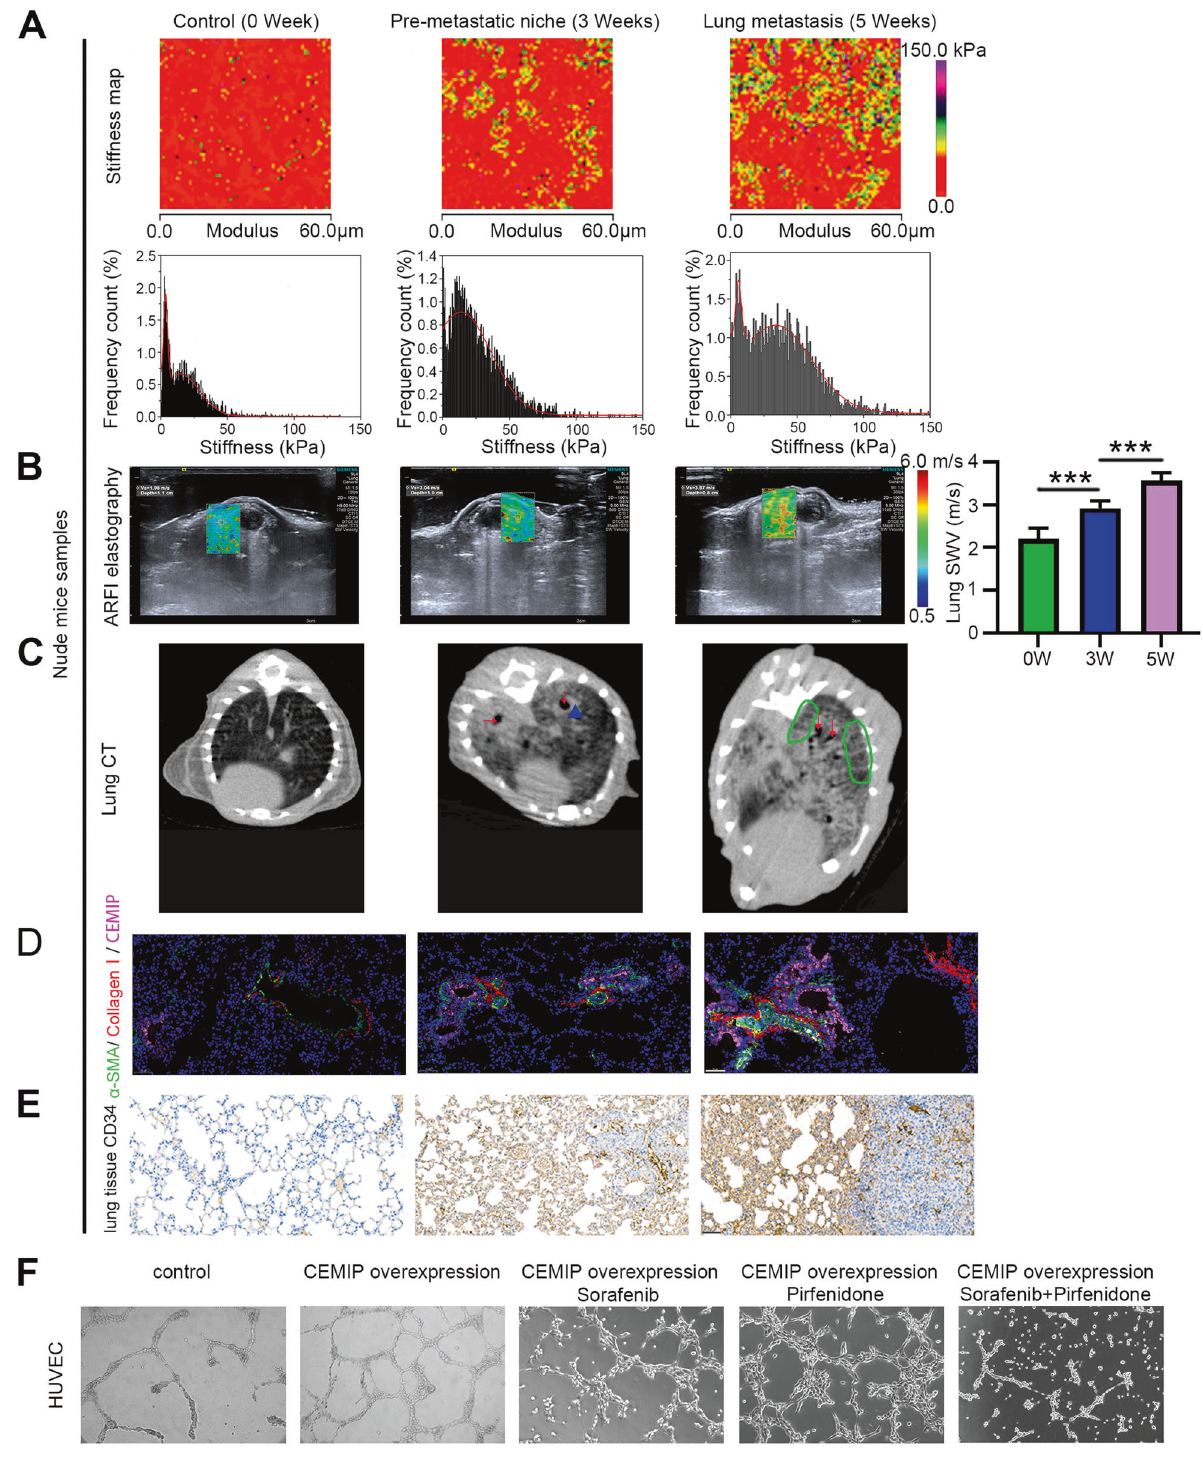
Fig. 4 CEMIP promotes angiogenesis by increasing ECM stiffness. A Stiffness maps and stiffness distribution of lung tissues were measured using AFM. Lung stiffness was signi fi cantly elevated in the 3-week-pre-metastatic niche and was highest in 5-week-lung metastases. B Comparison of wave speeds among 0-week, 3-week, and 5-week groups via SWE measurement *** P < 0.001. C Left: Normal CT appearance. Middle: The predominant abnormality is patchy and exhibits bilateral ground-glass opaci fi cation, peribronchial consolidation (blue triangle), and tractional bronchiectasis (red arrows), and its appearance was consistent with that of fi brosis. Right: Sagittal reformation shows numerous thickened interlobular septa (green circle), peripheral or peribronchial consolidation, and mild reticular changes representative of typical lung fi brosis. D Immuno fl uorescent staining of COL-I (red), α -SMA (green), and CEMIP (pink) on paraf fi n-processed lung tissue sections. Scale bar = 50 μ m. E CD34 staining of paraf fi n sections of lung tissues obtained from nude mice. Scale bar = 50 μ m. F Representative images of tube formation in HUVECs cultured on Matrigel-coated plates with CEMIP-overexpressing lentivirus treated with pirfenidone/sorafenib.